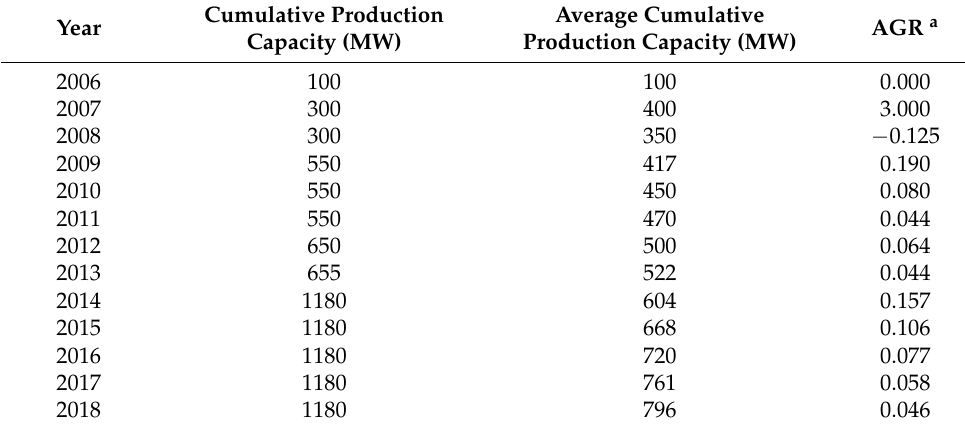
Table 5. Historical data on MFV manufacturing capacity in